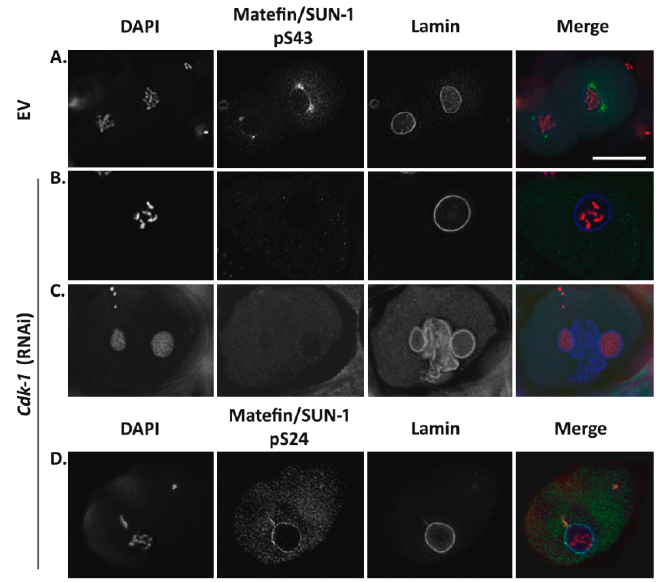
Figure 2. Matefin/SUN ‐ 1 pS43 is mediated by CDK ‐ 1. cdk ‐ 1 (RNAi) specifically eliminates matefin/SUN ‐ 1 pS43 staining in embryos. ( A ) embryos treated with an empty vector (EV); ( B – D ) embryos treated with cdk ‐ 1 (RNAi). Embryos stained with anti ce ‐ lamin (blue), DAPI ( red ) and anti matefin/SUN ‐ 1 pS43 ( A – C ) and pS24 ( D ) ( green ) antibodies. Scale bar 10 μ m.